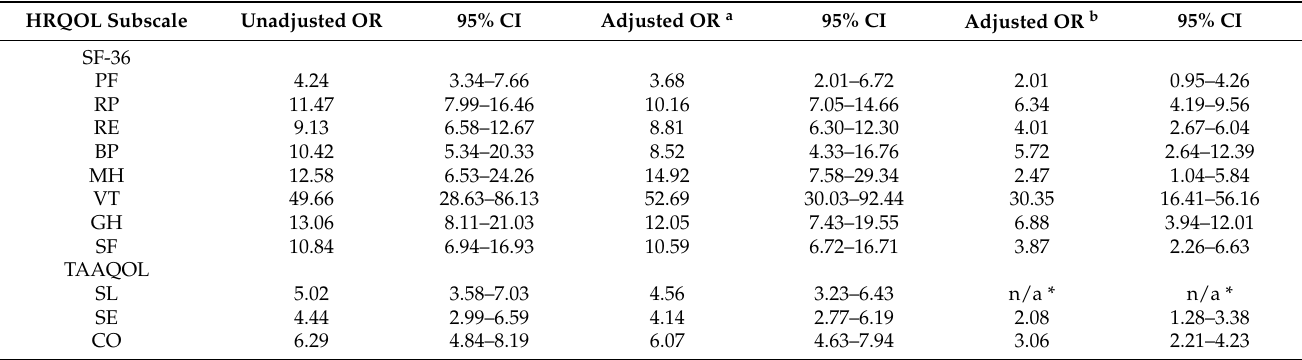
Table 2. Association of CF with impaired